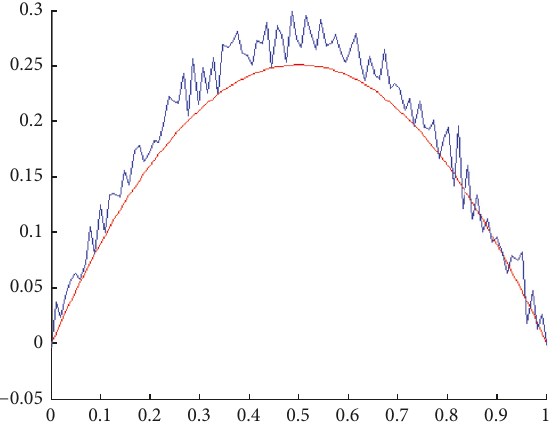
Figure 10: Final temperature.